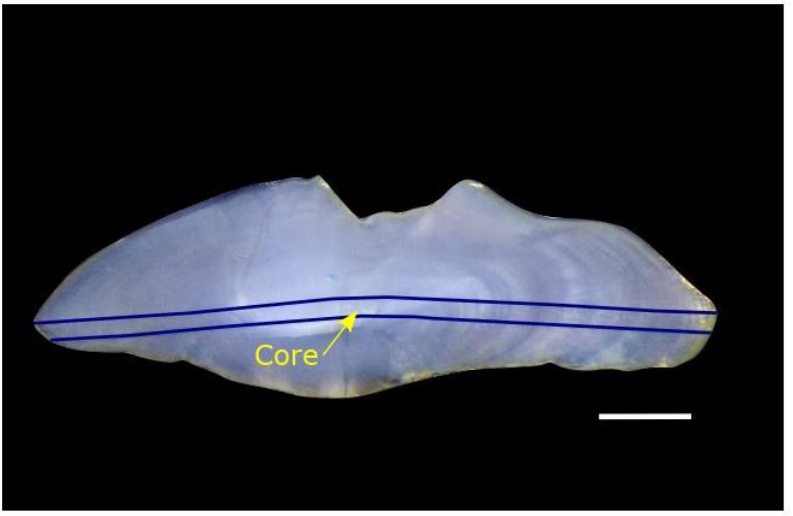
Figure 2. Otolith of juvenile Diplodus vulgaris . The blue line represents the line scan through the otolith core from one edge to the opposite edge. Scale bar = 100 µm (Magnification 3x). Data for each otolith were selected approximately on distance 200 µm from the core.